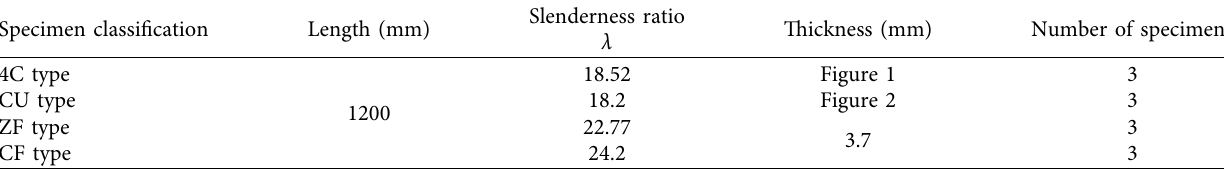
Table 1: Specimen conditions.